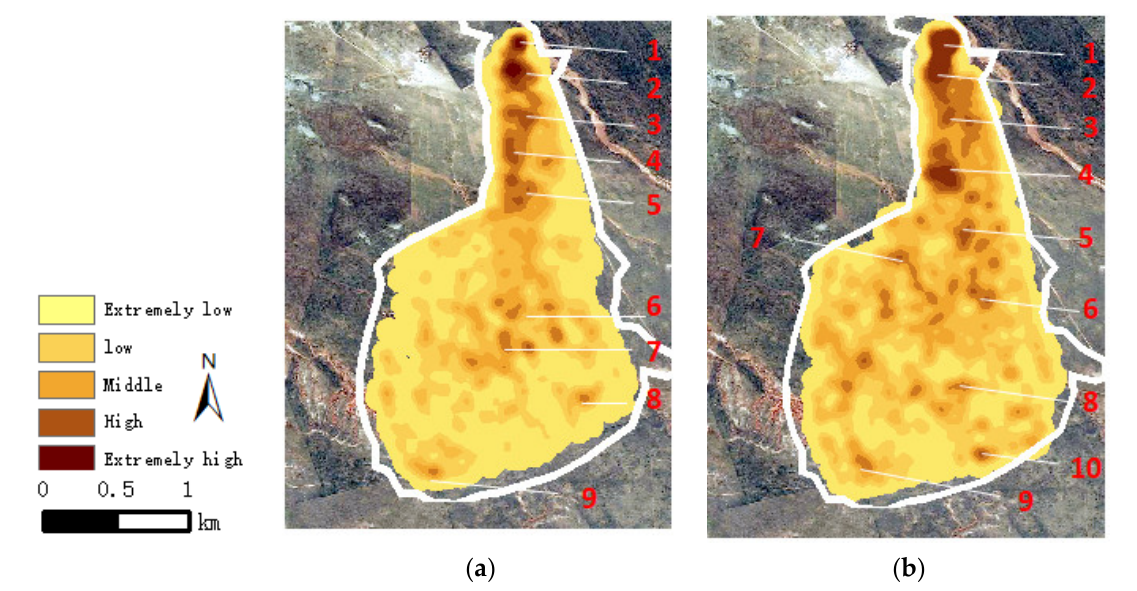
Figure 7. Kernel density map of sheep in summer and autumn. ( a ) Summer. ( b ) Autumn.